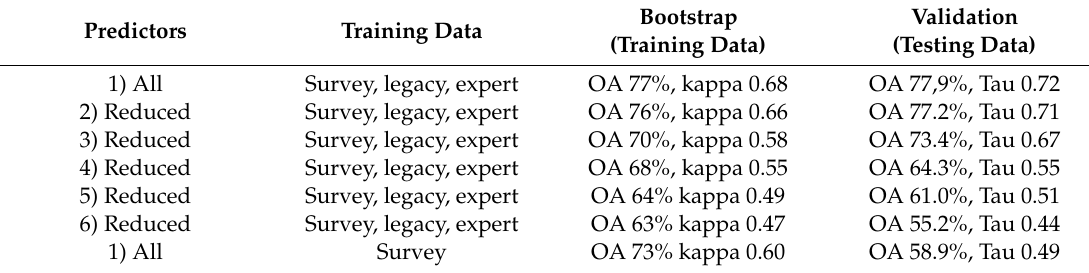
Table 7. Comparison of HUB 3 classification model overall accuracy (OA), Cohen’s kappa and Tau, when using di ff erent predictor variables and training data. The accuracy was calculated from the testing data (30% of 2016–2017 drop camera samples), and additionally by bootstrapping the training data in the model fitting stage (may show inflated accuracy numbers in case of overfitting). Predictor variables (all groups contained northing / easting): (1) Depth metrics 0.5 m–2 km, OBIA metrics